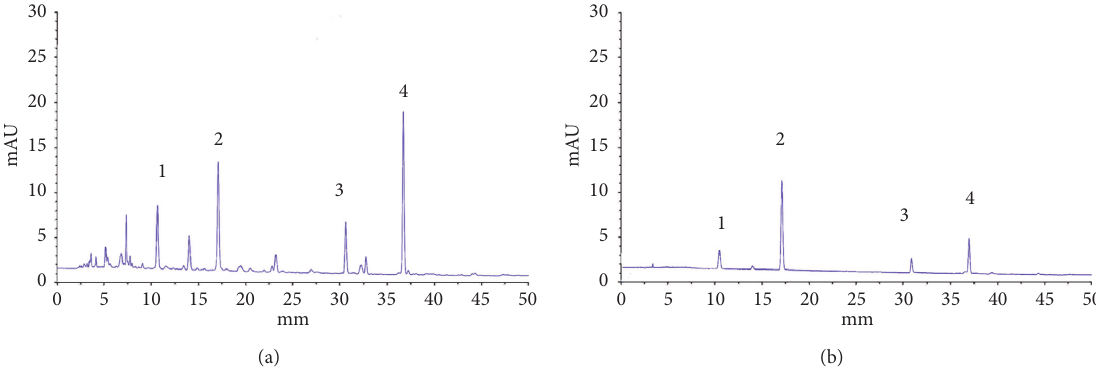
Figure 1: The representative HPLC chromatogram of gastrodin (1), p- hydroxybenzyl alcohol (2), parishin B (3), and parishin A (4) in Gastrodiae rhizoma steaming samples (A) and standard solution (B). Table 1: Main methodology parameters and calibration curves of the reference HPLC method. Analytes